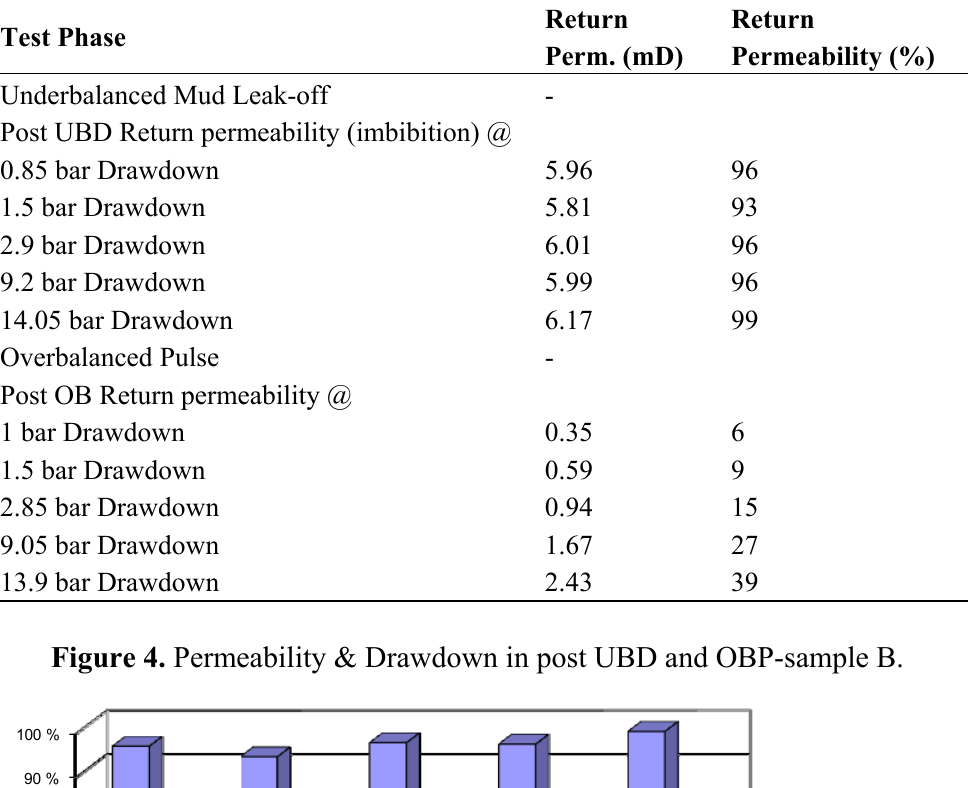
Table 5. UBD leak-off test with brine; Sample B, Permeability Summary.